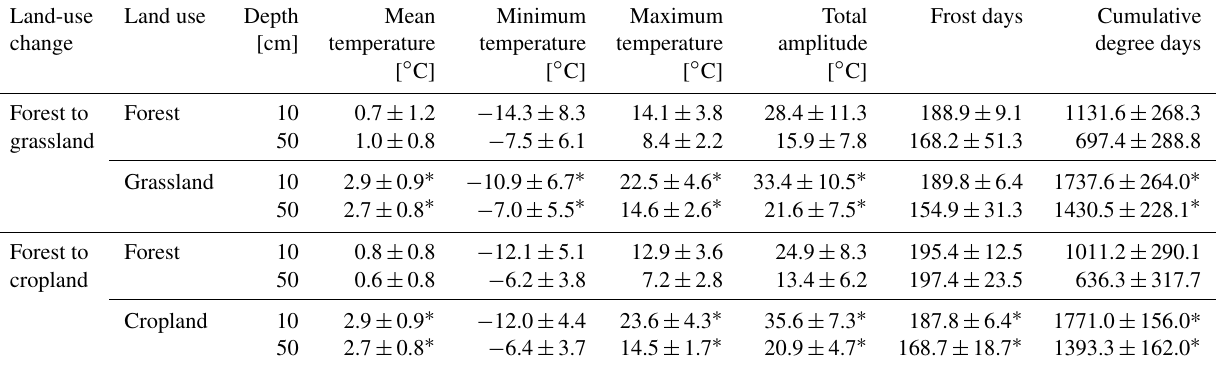
Figure 6. Correlogram of Pearson’s correlation coefficient, showing the correlation of mean potential litter decomposition and the most important soil temperature parameters, site characteristics, soil properties and fractions of organic soil matter (POM: particulate organic matter; S+C: silt and clay; S+A: sand and stable aggregates; DOC: dissolved organic carbon; MAOM: mineral-associated organic matter). The size and colour of the points represent the direction and the value of the correlation coefficient. Asterisks indicate statistical significance with ∗ p< 0 . 05, ∗∗ p< 0 . 01 and ∗∗∗ p< 0 . 001. Table 1. Mean, minimum and maximum temperature; temperature amplitude; number of frost days; and cumulative degree days on 0 ◦ C base in forest, grassland and cropland soils. Values are means with standard deviation. Asterisks indicate significant difference ( p< 0 . 05). Land-use Land use Depth Mean Minimum Maximum Total Frost days